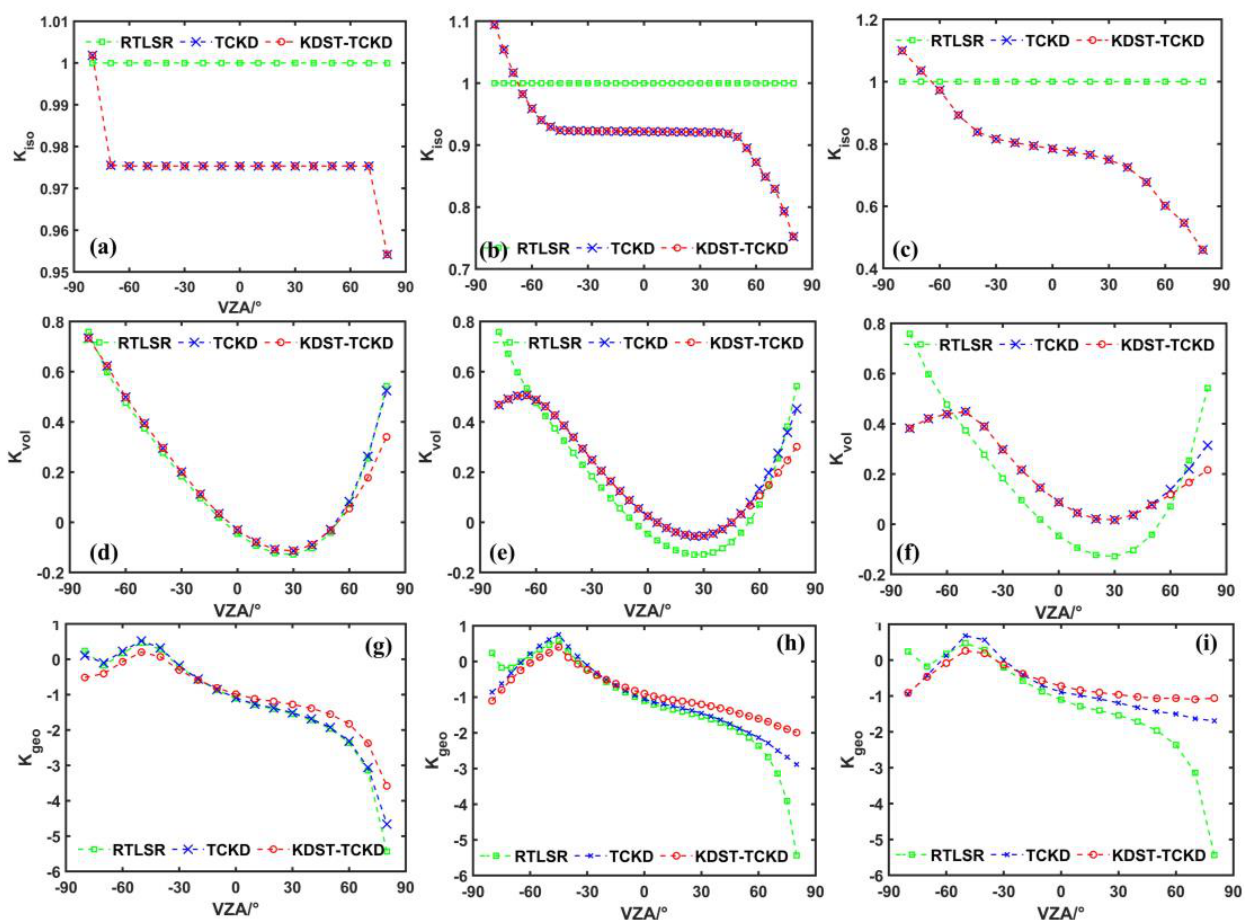
Figure 6. The kernel shape of the RTLSR, TCKD and KDST − TCKD (abbreviated as ‘Model’) models in the PP under different terrains (the three terrains in Section 3.1, ( a – c ) are the kernel shapes of the isotropic kernel, ( d – f ) are the volumetric-scattering kernel shapes, and ( g – i ) are the geometric–optical kernel). Columns from left to right are the three rugged terrains with mean slopes of 9.13°, 22.83°, and 33.40°, respectively.